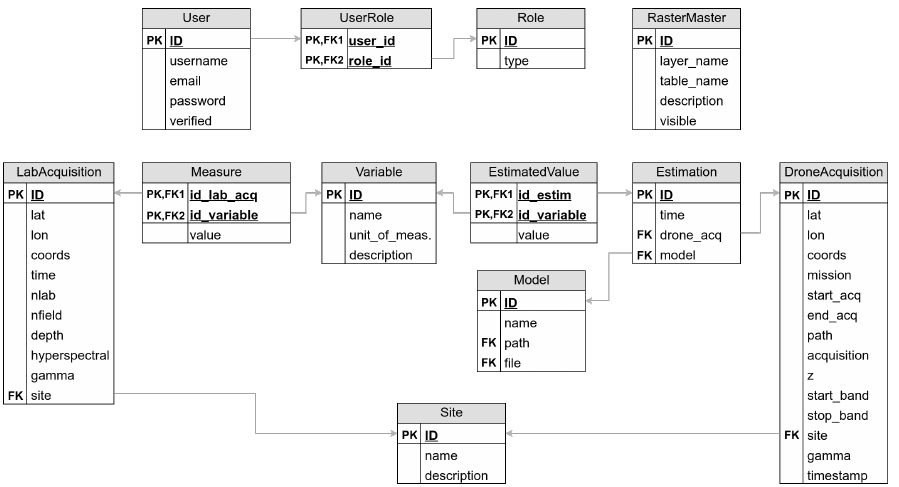
Figure 2. Database organization. It considers five aspects, the handling of users, the acquisitions made in the laboratory and with airborne sensors, the rasters, and finally the predictions made by predictive models on airborne-acquired data. The considered variables are not a static set, but they can easily change as the researchers focus on different characteristics of